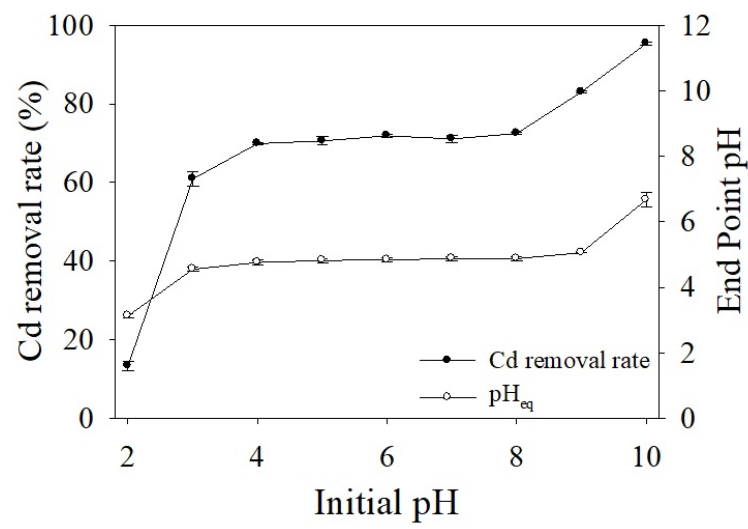
Figure 3. Cd removal rate ( ● ) by spent coffee grounds and the end point pH after equilibrium ( ○ ) with the increase in initial solution pH.